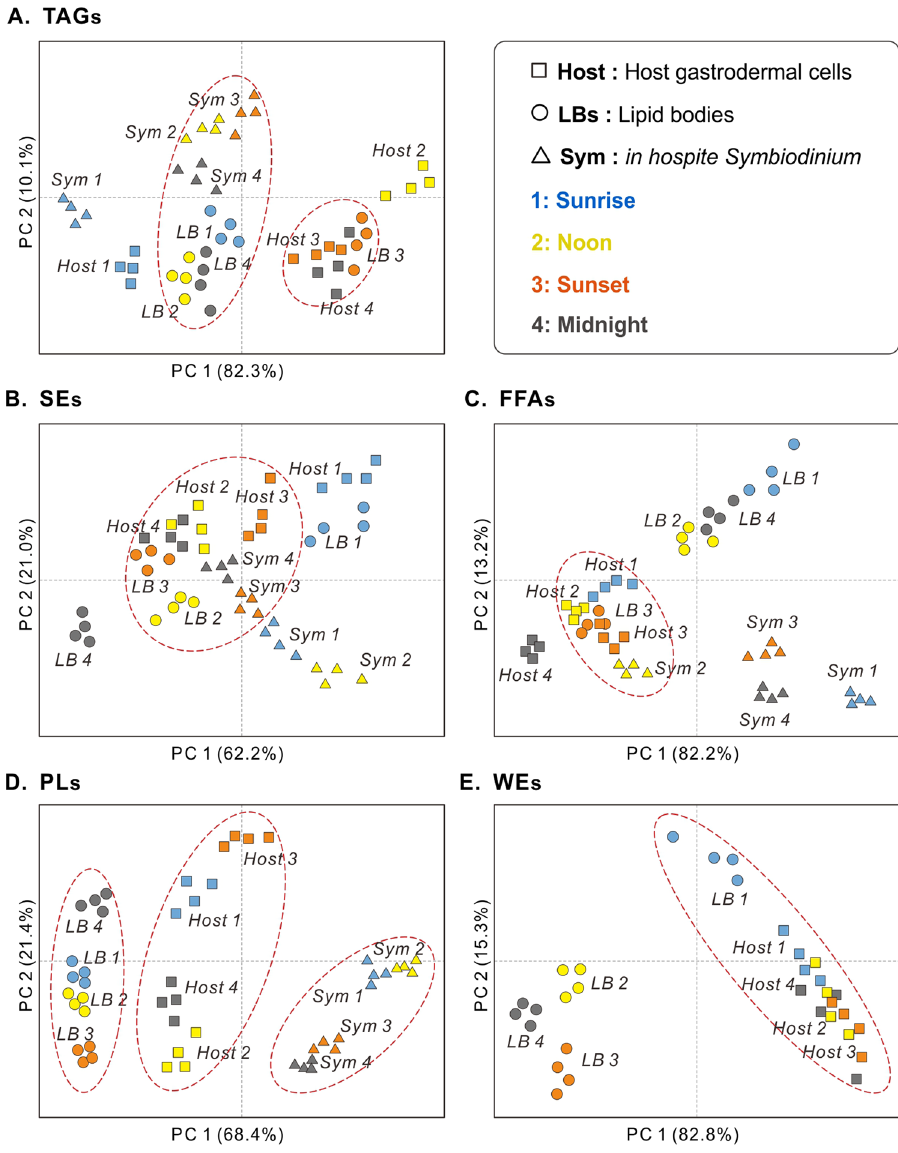
Figure 4. Temporal contribution of individual lipids to LB formation. Principal components analysis of FA moieties in individual lipid classes ( A ) TAGs, ( B ) SEs, ( C ) FFAs, ( D ) PLs, and ( E ) PCA of WE species among host coral gastrodermal cells (“Host,” squares), lipid bodies (“LBs,” circles), and in hospite Symbiodinium (“Sym,” triangles) across the diel cycle (blue: sunrise, yellow: noon, orange: sunset, and gray: midnight). The red dash circles presented to cluster the closely relation and strongly similarity of FA moieties after PCA across multiple